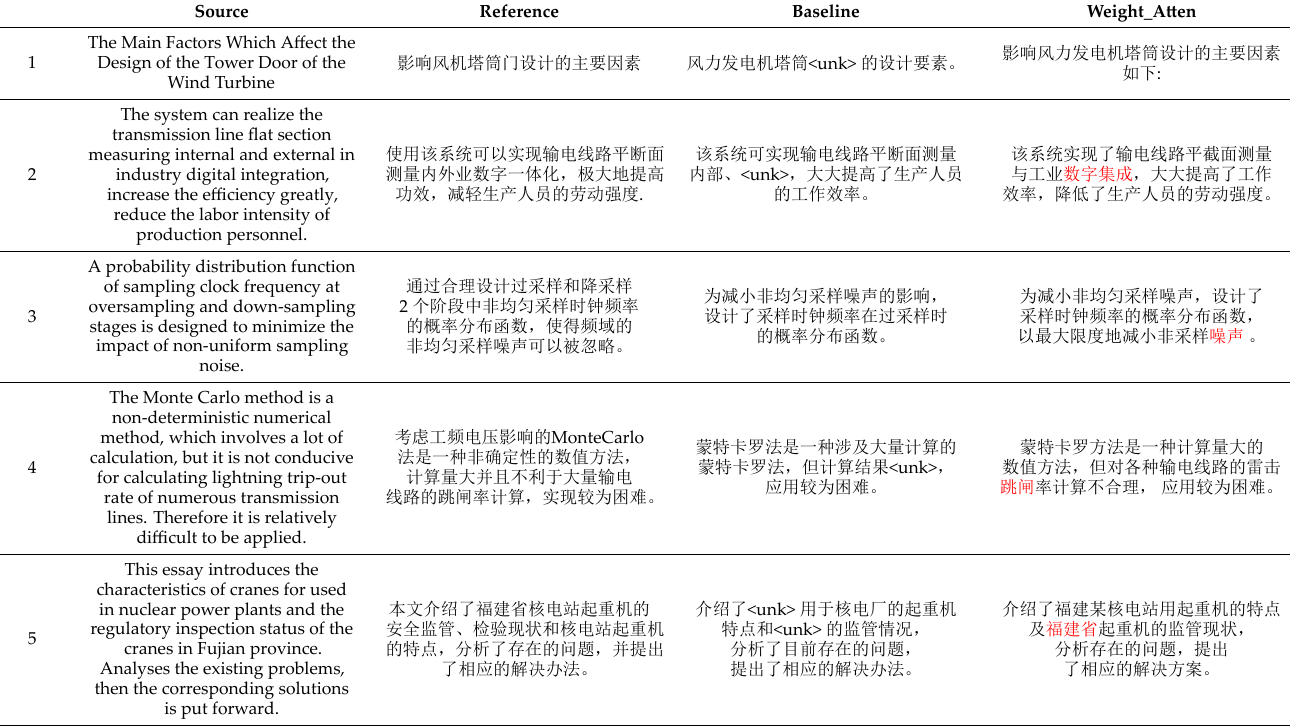
Table 4. Comparison of translation